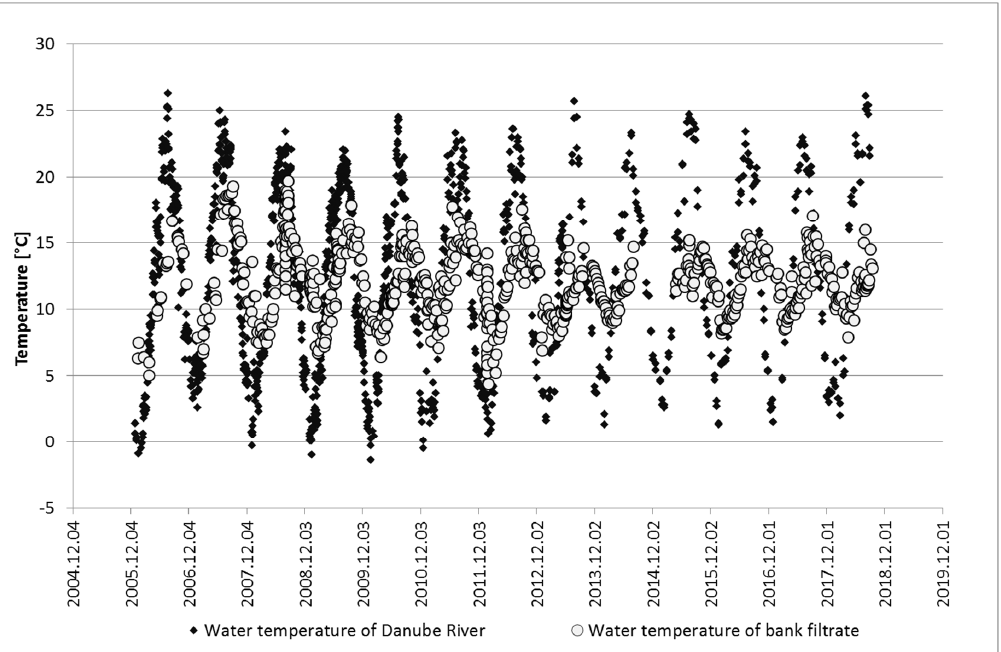
Figure 2. Seasonal temperature variation in Danube River water and bank filtrate, well group Balpart II, 2006–2018. II,